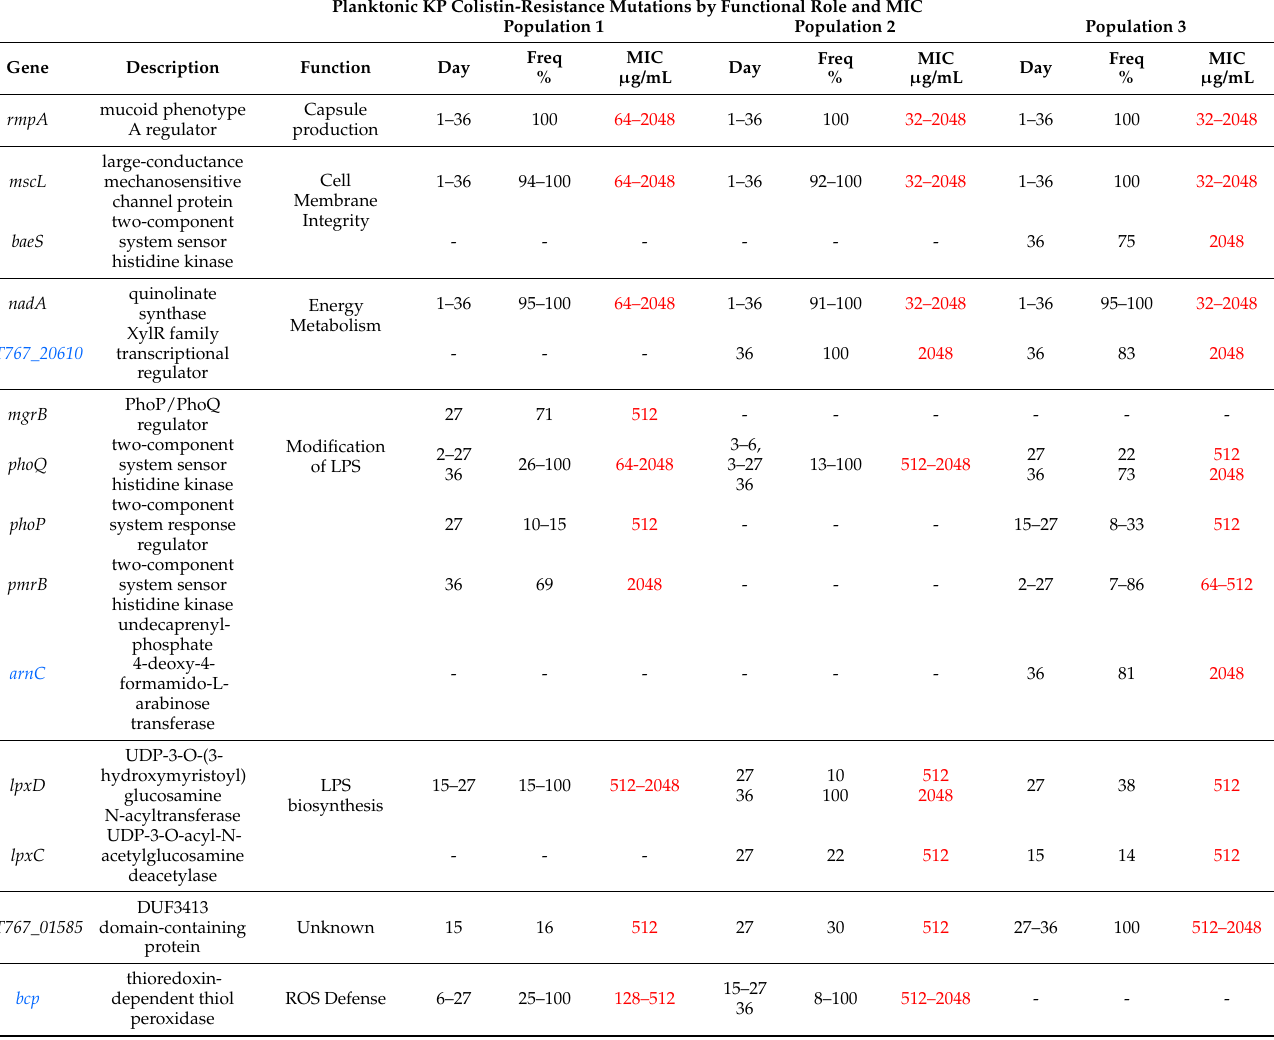
Table 3. Functional roles of COL-R mutations in relation to timing, population frequency (percentage), and colistin MIC ( µ g/mL) for planktonic-evolved KP. Resistant MICs are shown in red, and mutations independent to planktonic lifestyle are shown in